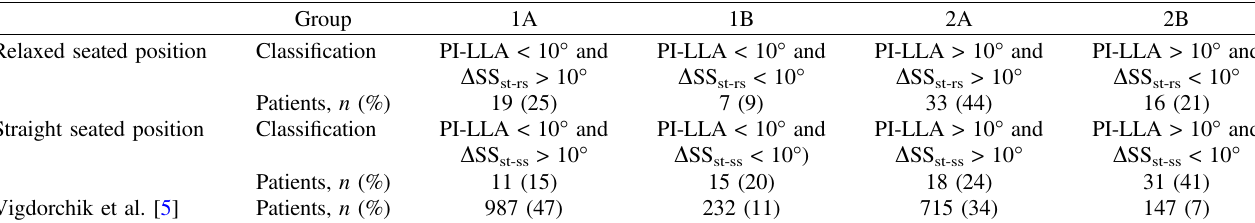
PI-LLA, pelvic incidence minus lumber lordosis angle; D SS st-rs , change in sacral slope from the standing to the relaxed seated position; D SS st-ss , change in sacral slope from the standing to the straight seated